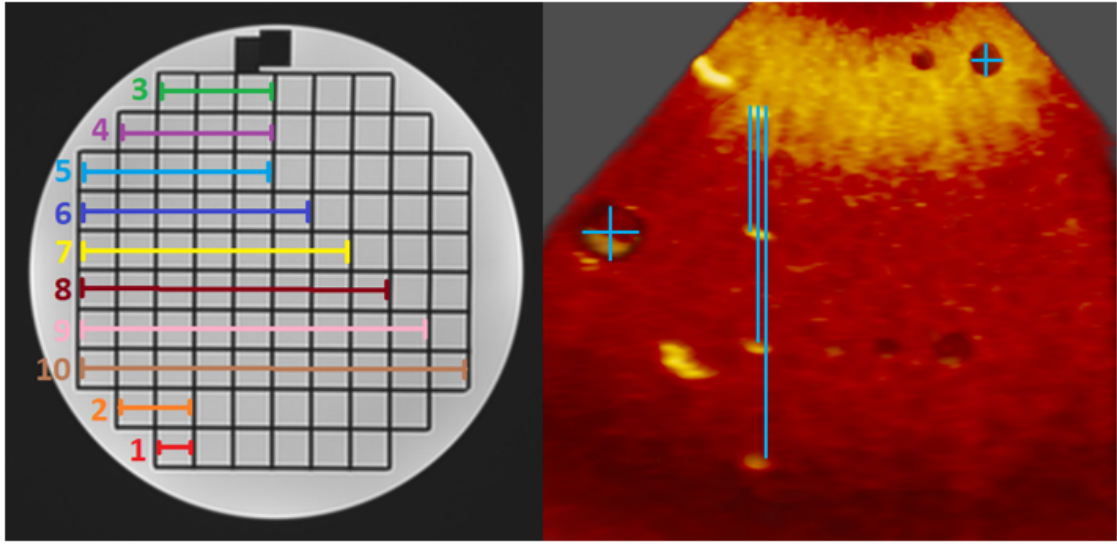
Figure 2. Schematic of measurements performed on CT and MRI phantom ( left ) and 3DE phantom ( right